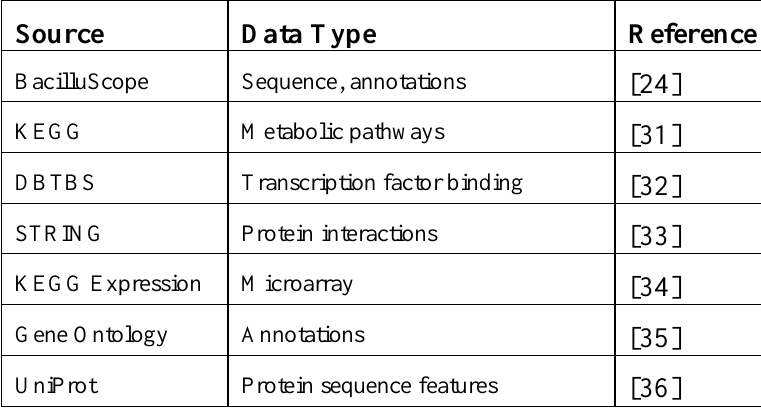
Table 1: Data sources used to construct